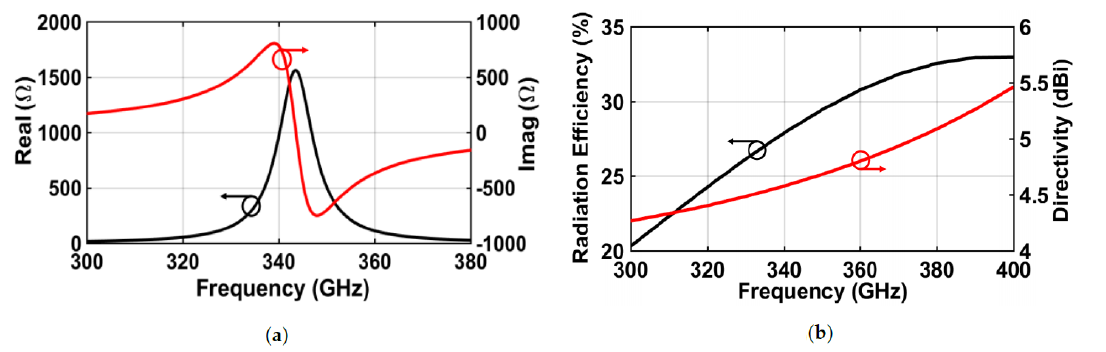
Figure 4. Simulation results of the bow-tie antenna: antenna impedance ( a ); antenna radiation efficiency and directivity ( b ).